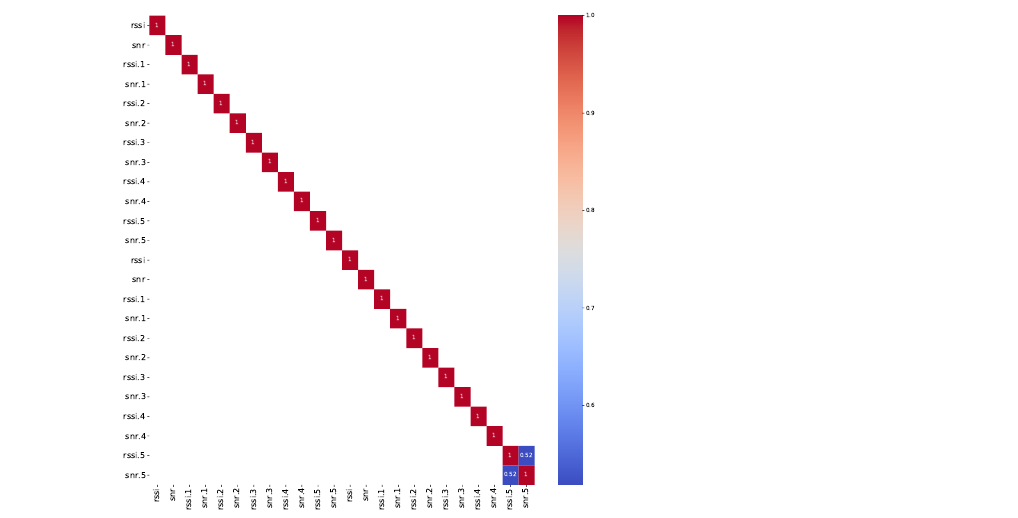
Figure 7. Data correlation for RSSI and SNR values for ROOM A507 and location points 2 and 3.